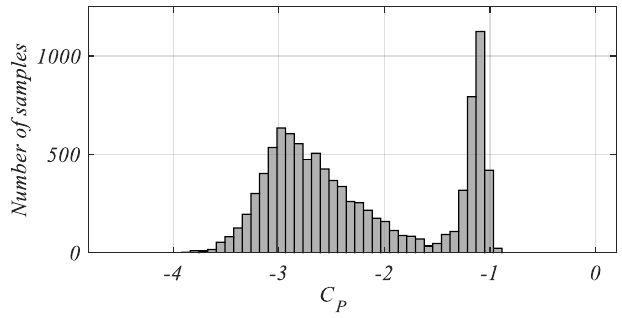
Figure 10. Histogram of C p samples at x/c = 0 for α = 22.5°.